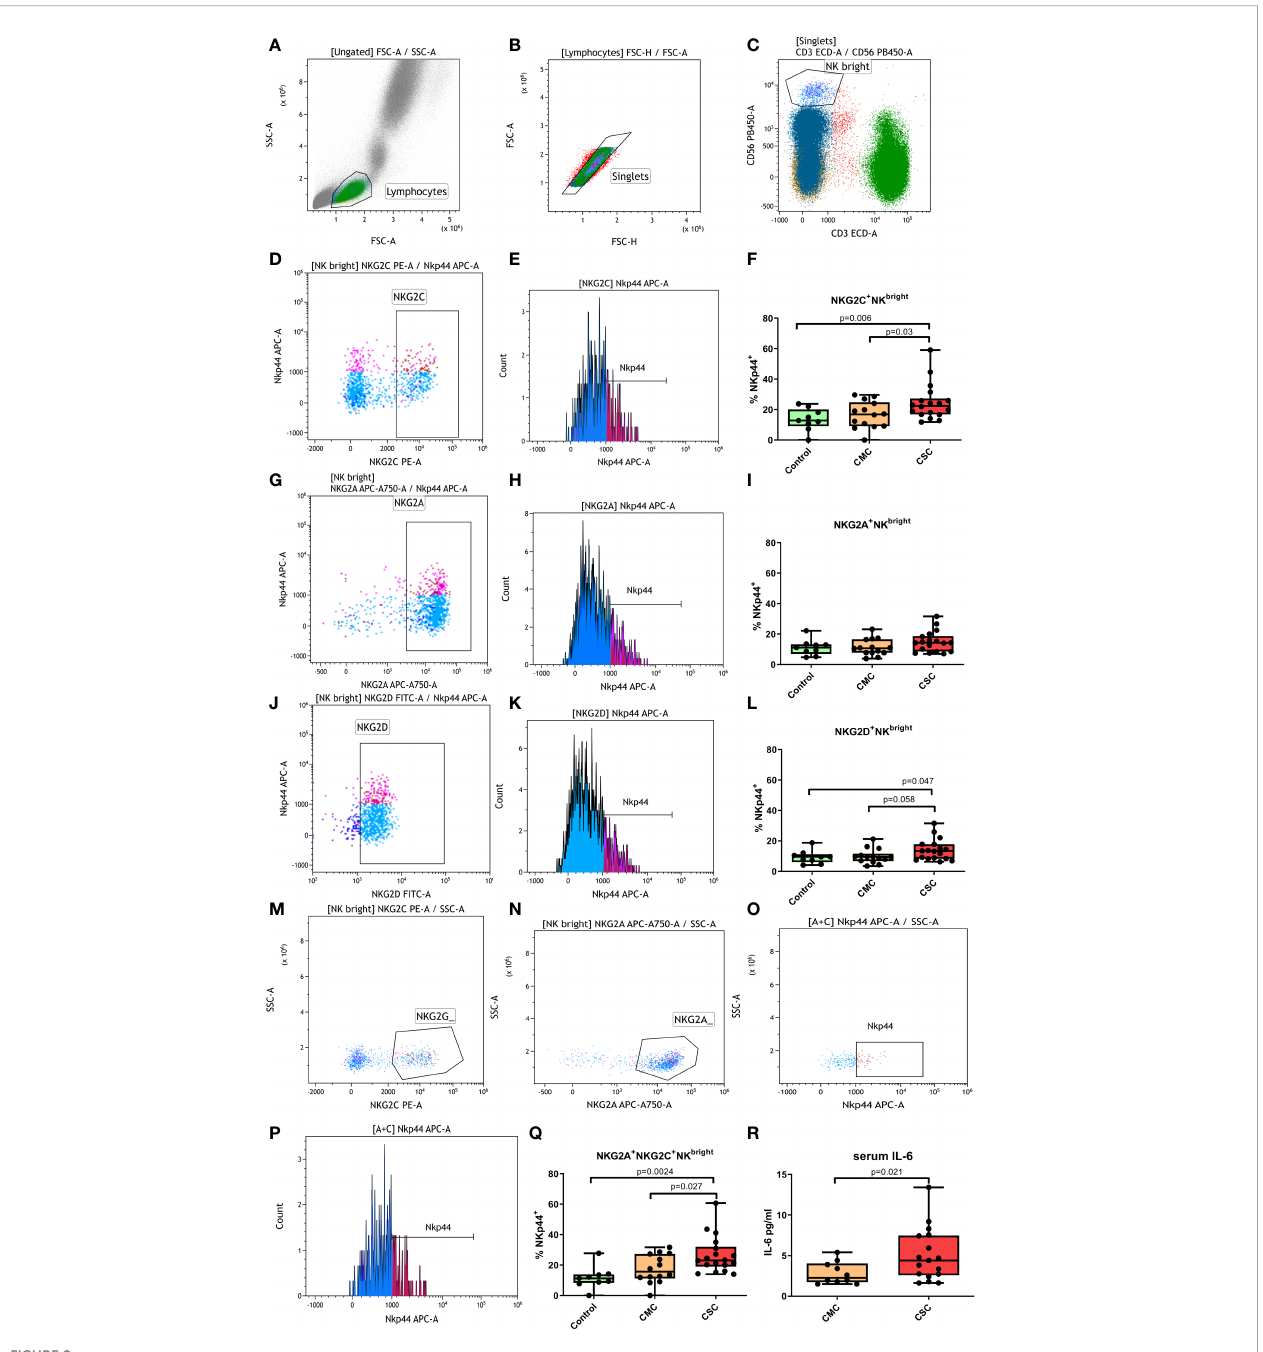
FIGURE 2 Percentage of NKp44 + cells in CD56 bright NK subpopulations. (A-C) Overall gating strategy: (A) Selection of lymphocytes by forward and side scatter. (B) Selection of single events. (C) Selection of CD56 bright NK cells. (D) Selection of NKG2C + CD56 bright NK cells. (E) Selection of NKp44 + cells within the NKG2C + CD56 bright NK population. (F) Percentage of NKp44 + NKG2C + CD56 bright NK cells in controls, CMC and CSC. (G) Selection of NKG2A + CD56 bright NK cells. (H) Selection of NKp44 + cells within the NKG2A + CD56 bright NK population. (I) Percentage of NKp44 + NKG2A + CD56 bright NK cells in controls, CMC and CSC. (J) Selection of NKG2D + CD56 bright NK cells. (K) Selection of NKp44 + cells within the NKG2D + CD56 bright NK population. (L) Percentage of NKp44 + NKG2C + CD56 bright NK cells in controls, CMC and CSC. (M, N) Selection of NKG2A + NKG2C + CD56 bright NK cells by a boolean gate that included all events in the CD56 bright window that were positive for NKG2C + (M) and NKG2A + (N) . (O, P) : Percentage of NKp44 + cells in the NKG2A + NKG2C + CD56 bright NK population. The NKp44 + population was determined in a histogram plot (P) and con fi rmed in a dot plot (O) . (Q) Percentage of NKp44 + NKG2A + NKG2C + CD56 bright NK cells in controls, CMC and CSC. (R) Levels of serum IL-6 in CMC and CSC. CMC/CSC: convalescent of mild/severe COVID-19 individuals. Boxes represent the 25 and 75% quartiles, lines represent the median of the distribution, and whiskers are the maximum and minimum values of the